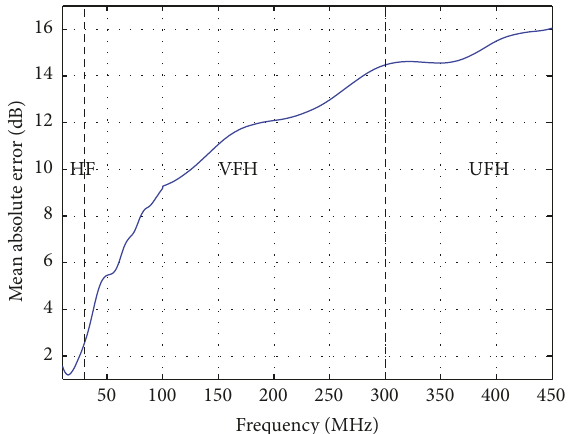
Figure 8: The mean absolute error of the Doppler spectral intensity over operating frequency between the SPM and the numerical method. The sea waves are linear and the wind speed is 10